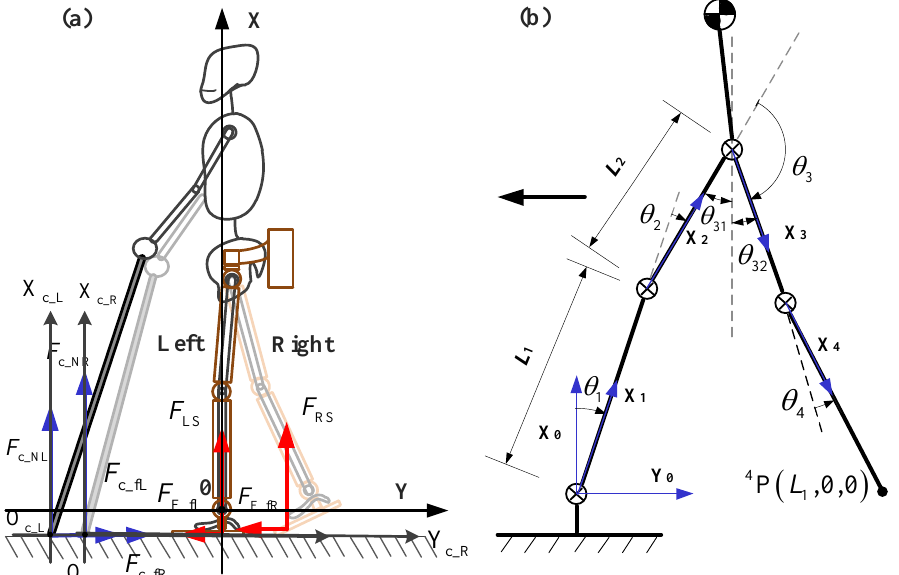
Figure 1. Human-exoskeleton-crutch system in the sagittal plane. ( a ) The local coordinate system is located at the rotation center of support of the leg ankle joint. The L/R crutch coordinate is located at the endpoint of the crutch. ( b ) Four-DoF kinematic model of the lower-limb exoskeleton. Denavit-Hartenberg parameters are tagged, including axes on joints and rotation angles of adjacent links.